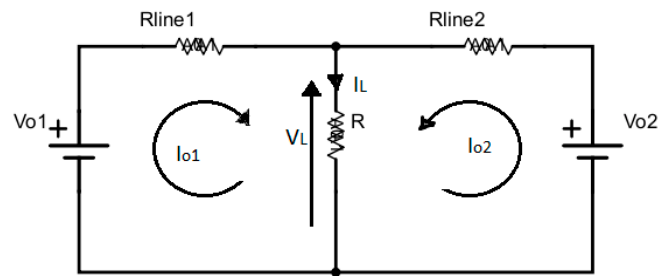
Figure 4. Parallel connected converters sharing a common load.